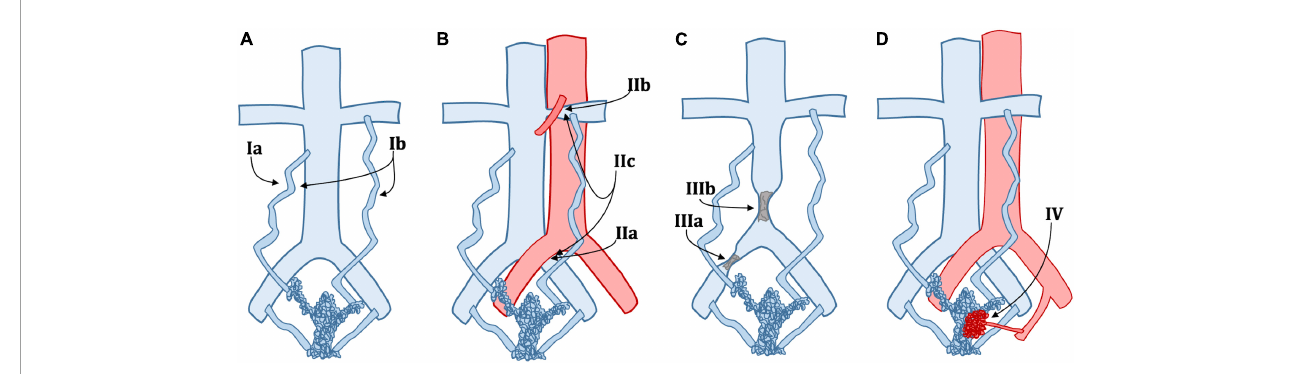
FIGURE1 Schematic classification of pelvic venous disorders (PeVD). (A) Type Ia: unilateral venous insufficiency, Type Ib: bilateral venous insufficiency; (B) Type IIa: May-Thurner syndrome, Type IIb: nutcracker phenomenon, Type IIc: both IIa and IIb; (C) Type IIIa: common iliac vein obstruction, Type IIIb: inferior vena cava obstruction; (D) Type IV: arteriovenous malformation or fistula. Type IId (extrinsic compression), IIIc (portal hypertension), and V (nutcracker Syndrome) are not